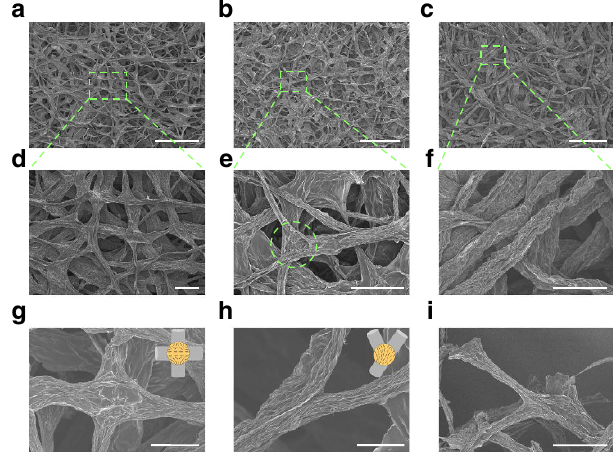
Figure 5 | Microstructure of GOFFs and GFFs. SEM images of ( a ) 130GOFF, ( b ) 130GFF-3,000 and ( c ) 200GFF-3,000. ( d – f ) Magnified images of a – c . SEM images highlighting the ( g ) X-type junction, ( h ) Y-type junction and ( i ) a well-preserved junction at the broken end of 130GFF- 3,000. Insets in g , h depict the arrangement of graphene sheets within X-type junction and Y-type junction. Scale bars, 500 m m ( a – c ), 100 m m ( d , e , f , i ) and 50 m m ( g , h ).